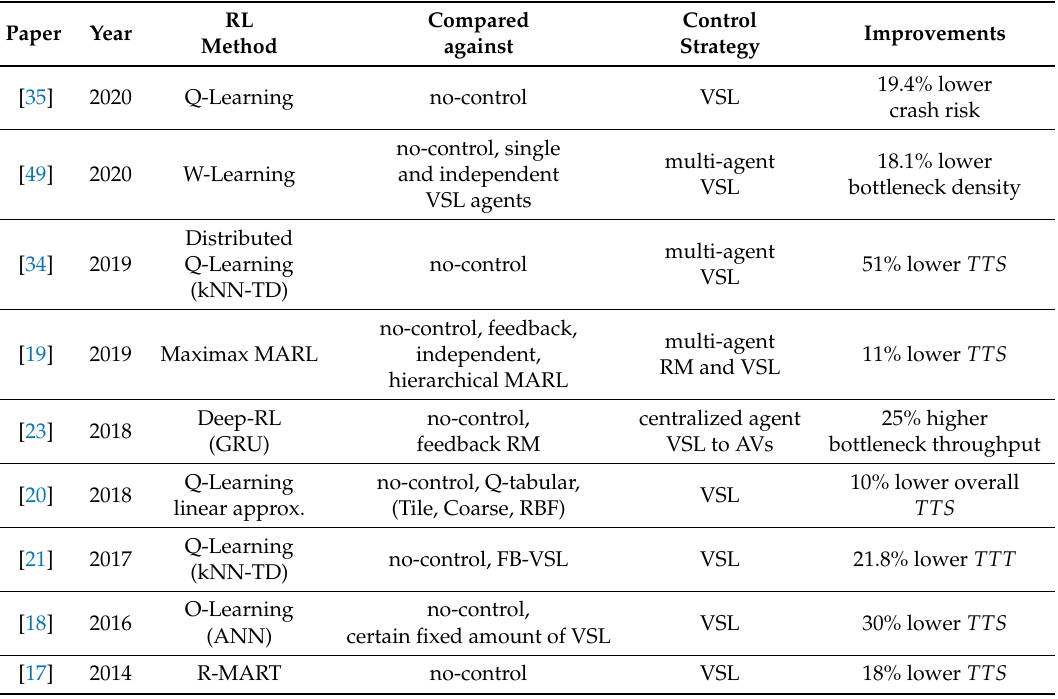
Table 1. The most representative Reinforcement Learning (RL) frameworks for VSL